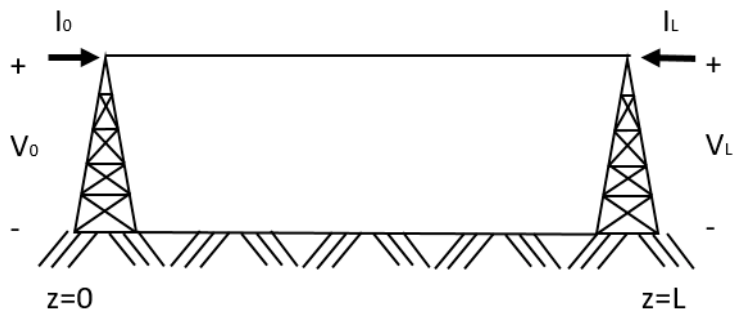
Figure 1. Uniform transmission line representation. V 0 and V L are the voltages of the sending and receiving node, and I 0 and I L are the injected currents at the sending and receiving node, respectively, and L is the line’s length .